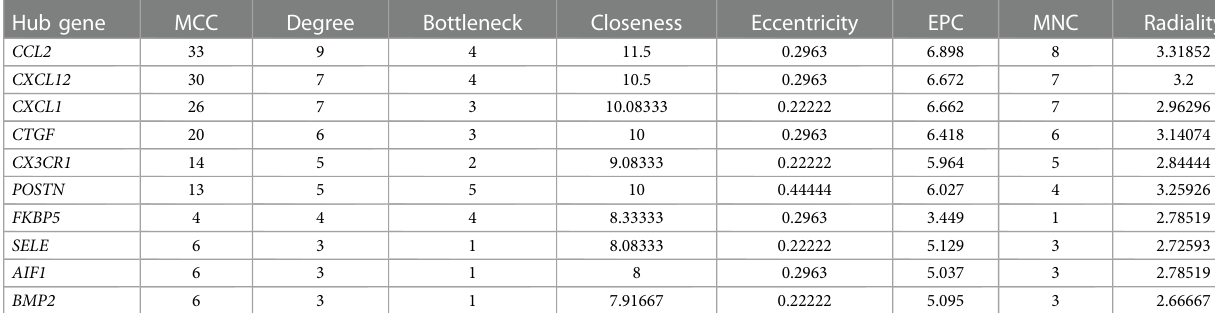
TABLE 1 Results of the top 10 hub genes ’ eight algorithms. Hub